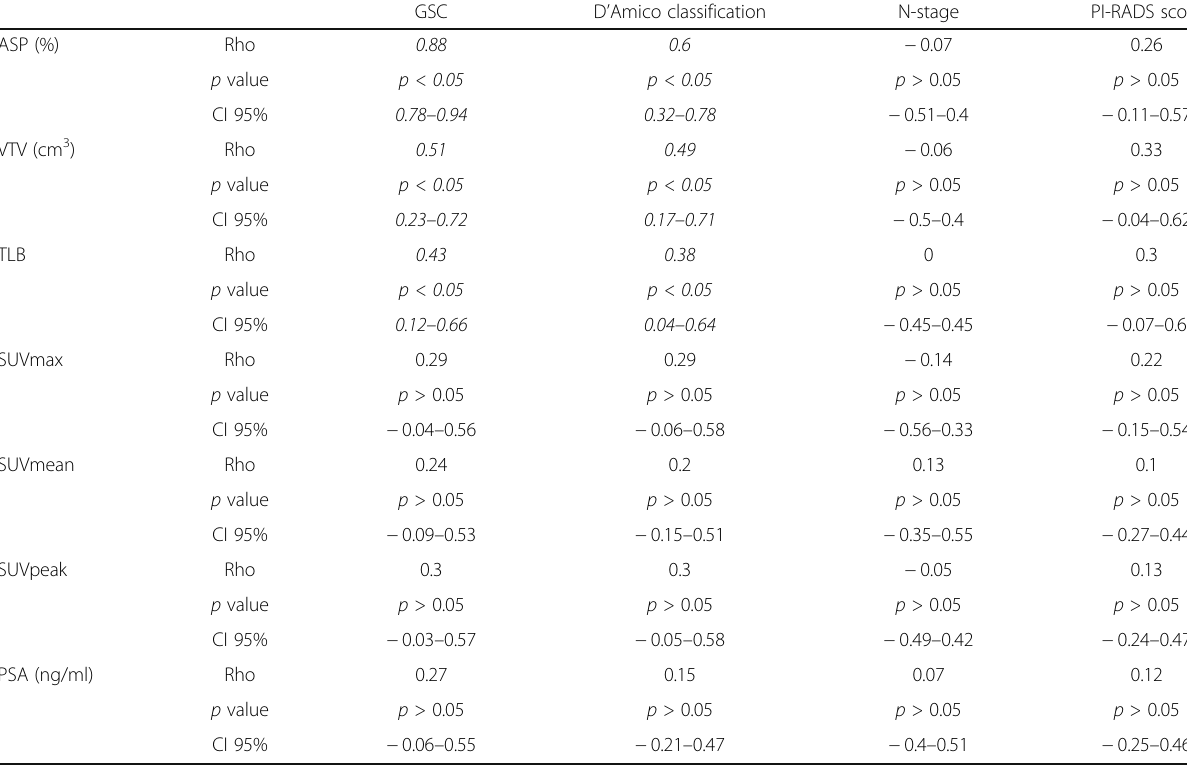
Spearman ’ s rank correlation method. This table summarizes the associations between the ASP, VTV, TLB, SUVmax, SUVmean, SUVpeak and PSA in the left column and the GSc, D ’ Amico classification, N-stage and the PI-RADS score in the upper row using Spearman ’ s rank correlation method. The closest significant ( p < 0.05) correlations were measured between ASP and GSc followed by a moderate correlation towards the D ’ Amico classification. A significant ( p < 0.05) weak correlation was seen between VTV and the GSc. Statistically significant correlations ( p < 0.05) are highlighted in italics. Abbreviations: ASP asphericity, VTV viable tumor volume,